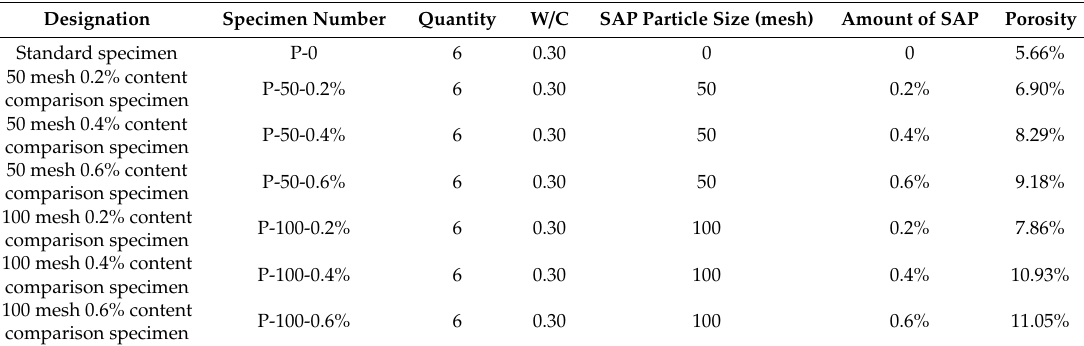
Figure 4. Permeation specimens and results. Table 3. Grouping and numbering of the specimens.